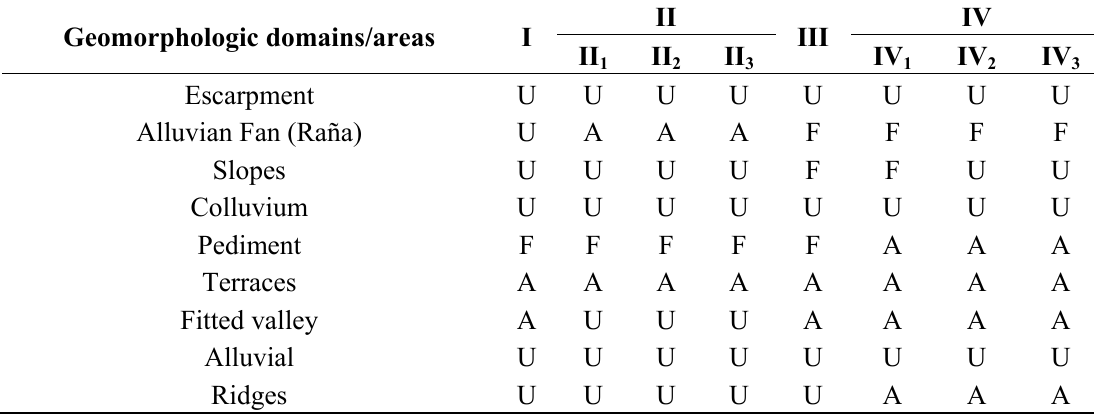
Table 2. Matrix capability suitability: (U) unfavourable, (F) favourable and (A)